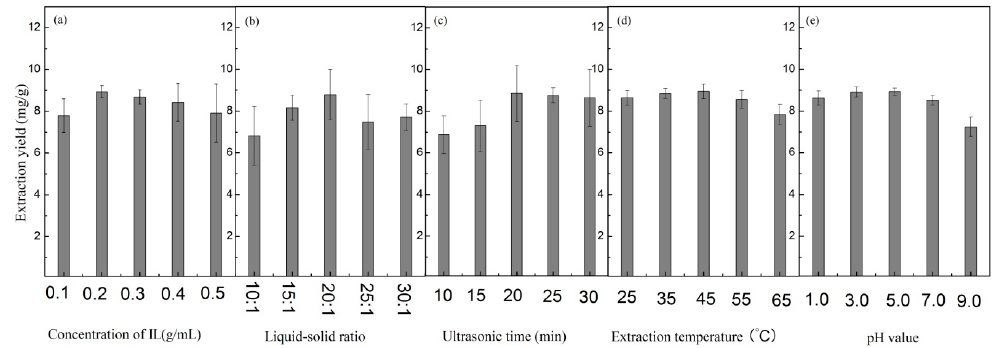
Figure 3. The effect of ( a ) IL concentration (the extraction conditions were 20:1 liquid/solid ratio, 30 min ultrasonic time at room temperature with pH being not adjusted); ( b ) liquid/solid ratio (the extraction conditions were 0.2 g/mL IL concentration, 30 min ultrasonic time at room temperature with pH being not adjusted); ( c ) ultrasonic time (the extraction conditions were 0.2 g/mL IL concentration, 20:1 liquid/solid ratio at room temperature with pH being not adjusted); ( d ) extraction temperature (the extraction conditions were 0.2 g/mL IL concentration, 20:1 liquid/solid ratio, 30 min ultrasonic time with pH being not adjusted); and ( e ) pH value (the extraction conditions were 0.2 g/mL IL concentration, 30 min ultrasonic time, 20:1 liquid/solid ratio at room temperature) on the extraction yields by UAE.